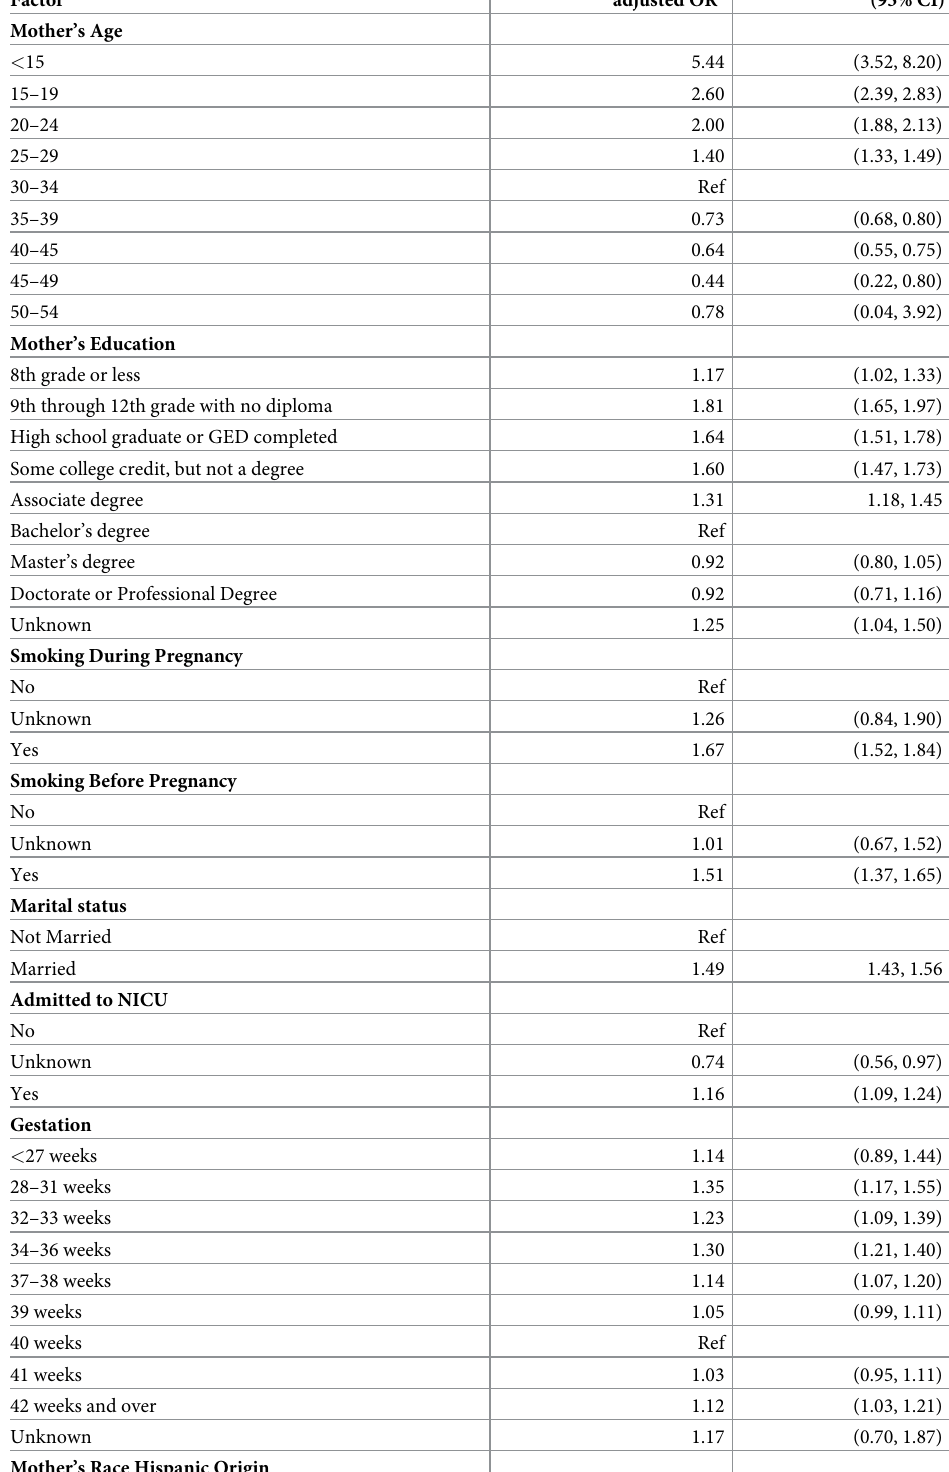
Table 4. Adjusted covariates for